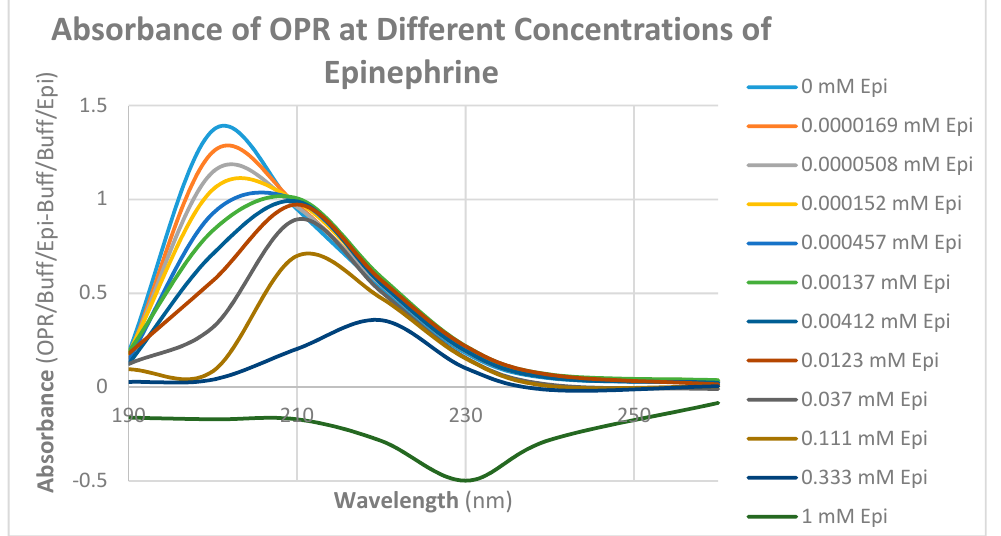
Figure 13. UV spectra of mu opioid receptor (OPR) with serial additions of epinephrine HCl (Epi). Note the very significant differences between these spectra and those in Figures 10 and